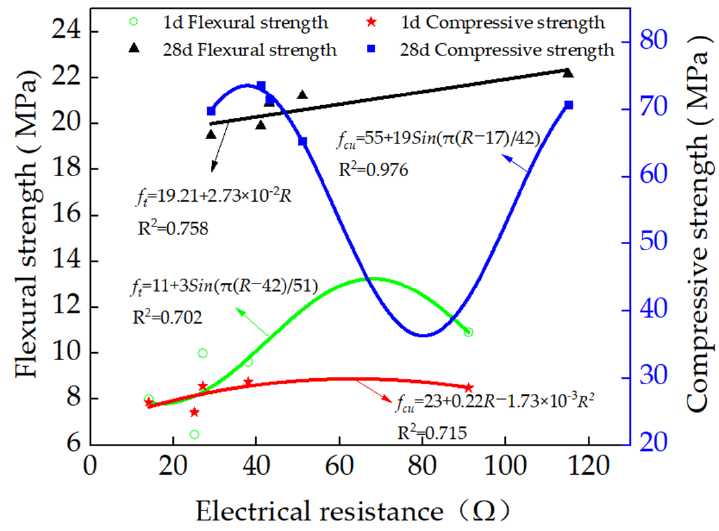
Figure 9. The relationship between flexural and compressive strengths and electrical resistance.